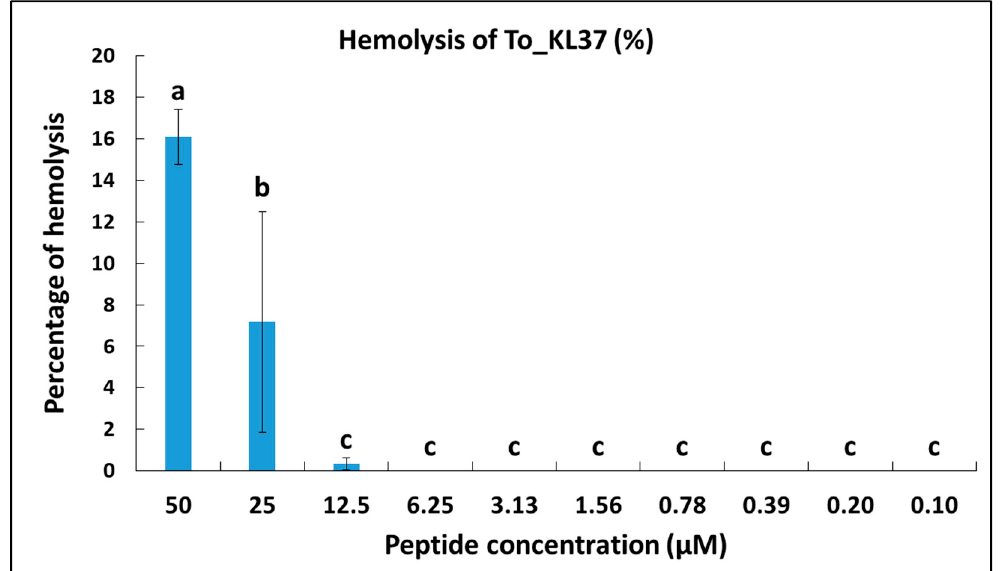
Figure 8. Percentage of hemolysis of human red blood cells in the presence of different concentrations of the synthetic peptide To-KL37, between 50 and 0.1 µM. a,b,c Means with different superscript letters differed significantly ( p < 0.05), using one-way ANOVA and Tukey's test.